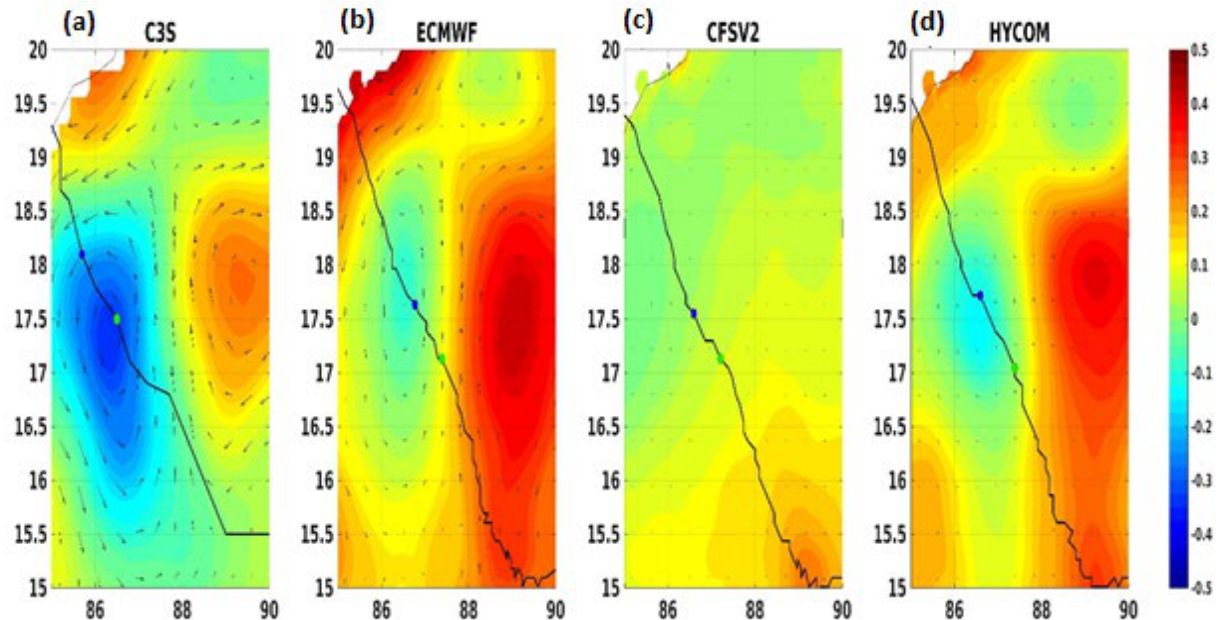
Figure 11. Spatial distribution of sea surface height anomalies (SSHA, shading) and geostrophic currents (vectors) from C3S (for SSHA) and CMEMS (for geostrophic currents) observations and from the experiments. The track observed by the IMD is shown with the C3S-observed SSHA, while the simulated tracks (black lines) are shown for each of the experiments. The positions of the TC at 48 h (green marker) and 54 h (blue marker) are also shown. The C3S observations were remapped at the resolution of the simulations.